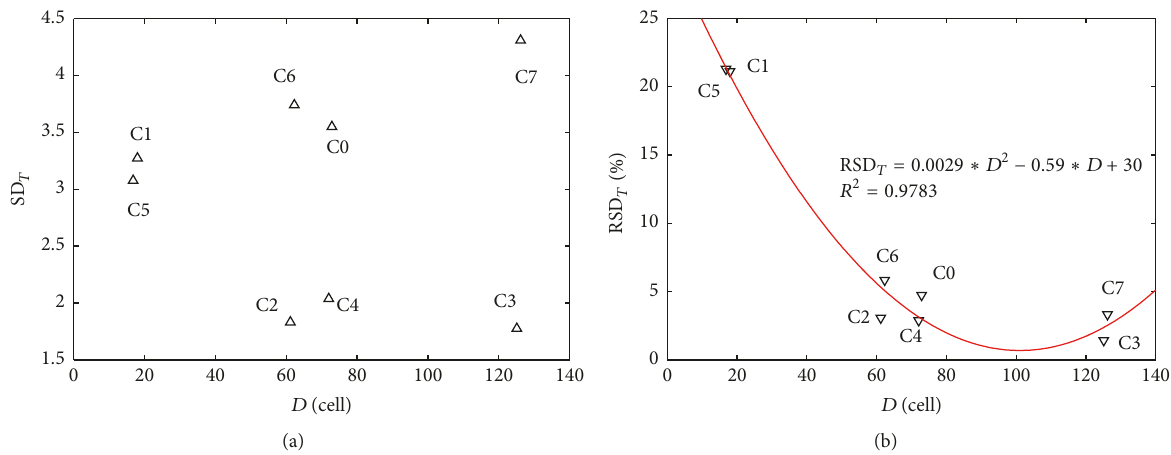
, and 𝐷 , where (a) is 𝑇 and (b) is 𝑇 average